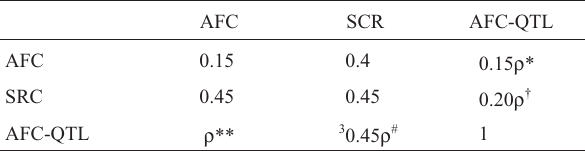
*Phenotypic correlation between AFC and AFT-QTL ( h AFC ρ = 0.15 ρ ). † PhenotypiccorrelationbetweenSCRandAFC-QTL( r